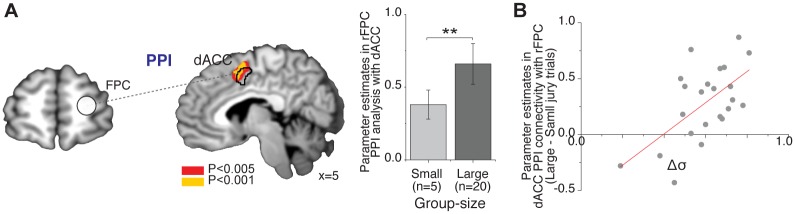
Functional connectivity between lateral frontopolar cortex (FPC) and dorsal anterior cingulate cortex (dACC).(A) Psychophysiological interactions (PPI) analyses. The PPI used the right lateral FPC as a seed (sphere of diameter = 10 mm centered at [x,y,z] = [42,44,19]). The functional connectivity between right FPC and dACC increased when group size increased (P < 0.05, family-wise error [FWE] corrected within small volume correction [SVC]). Error bars represent the standard error of the mean (SEM) (**, P < 0.001). (B) Between-subject regression analysis considering the individual difference in the relative credibility of social information (Δσ) as a covariate for the modulation of connectivity between dACC-FPC when presented with social information of the large versus the small group (P < 0.05, FWE corrected within SVC). The scatter plot was not used for statistical inference (which is carried out in the SPM framework). It is shown solely for illustrative purposes. The functional MRI (fMRI) data can be found in http://neurovault.org/collections/2503/. The data underlying this figure can be found in S1 Data.